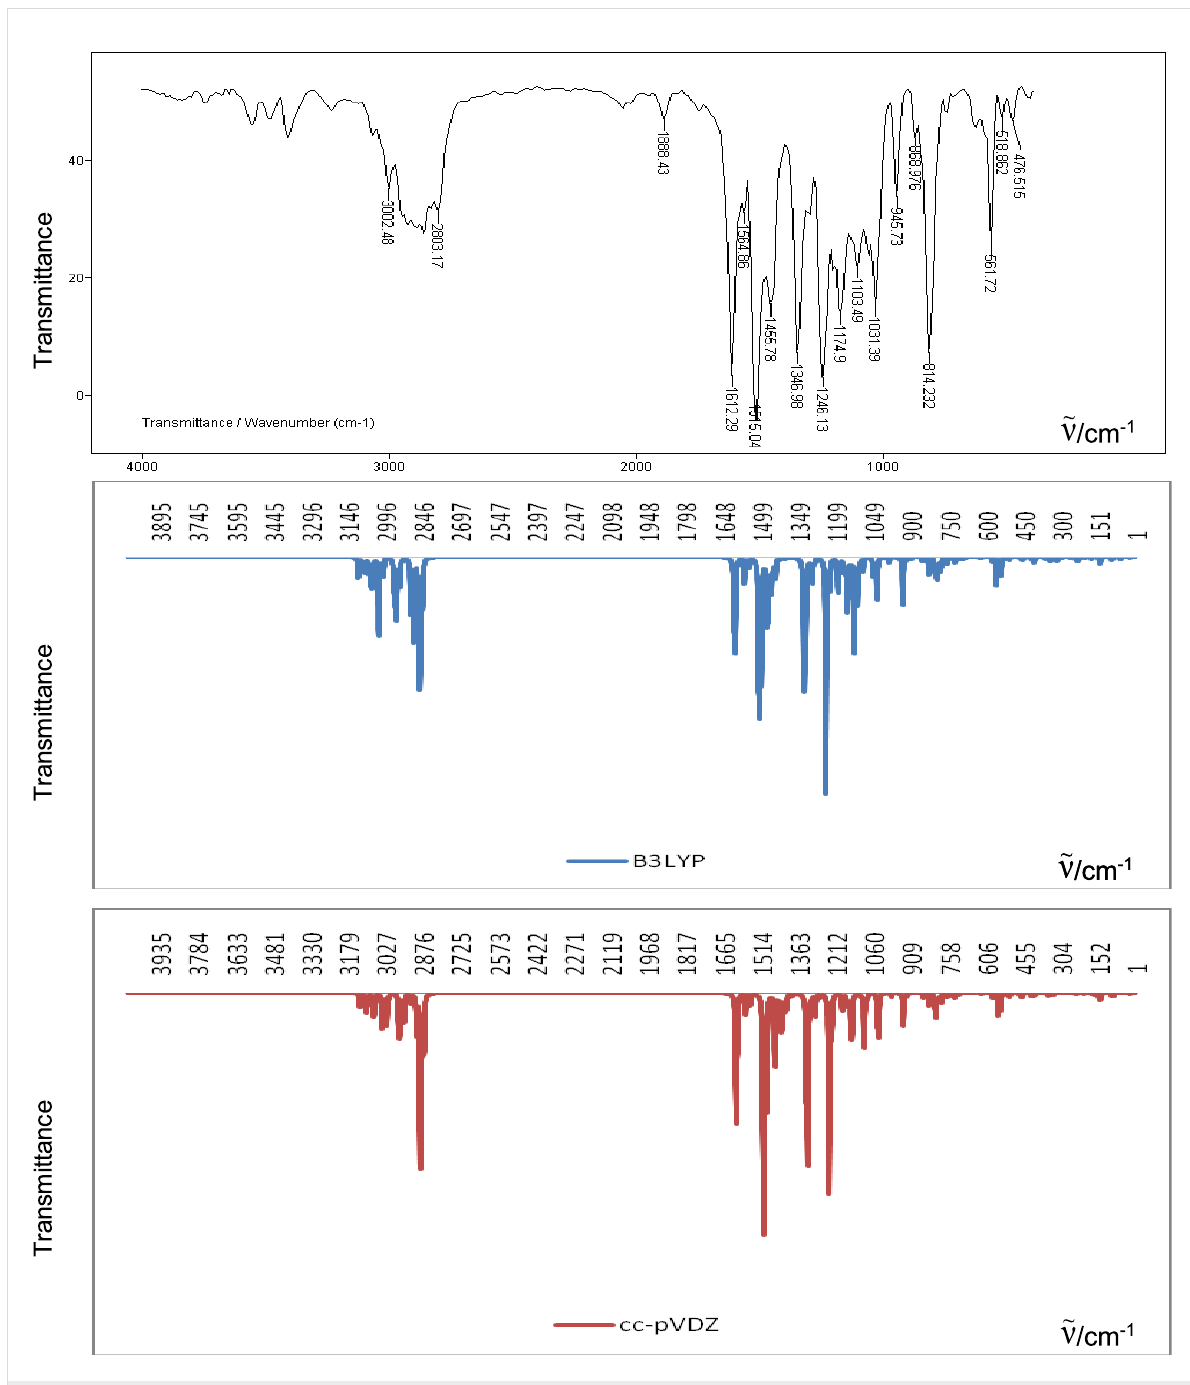
compounds where the bond lengths are 137.8 and 140.0 pm [49]. Although there are some differences between our results and those from X-ray structure analysis of similar compounds, the optimized structural parameters are very close to the X-ray values and are good enough for further vibrational